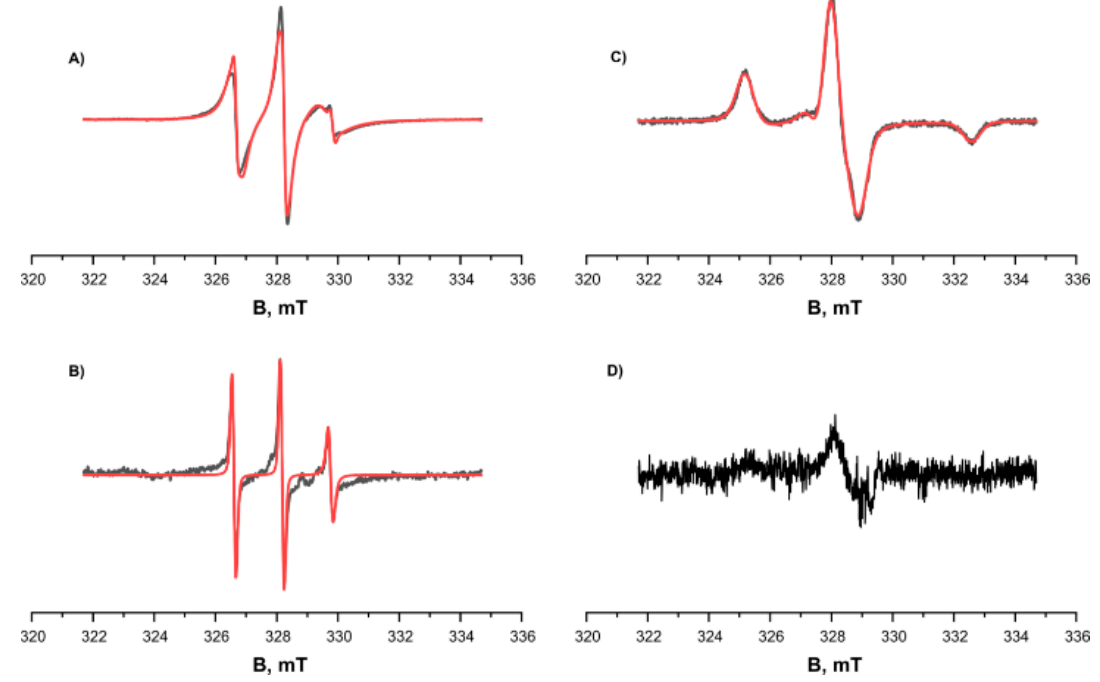
Figure 4. CW EPR spectra of RL2-MTSL at di ff erent temperatures and di ff erent pH levels (black curve: experimental, red one: simulated). ( A ) and ( C ) pH = 3.9, acetate bu ff er, 50% D 2 O, 50% deuteroglycerol. ( B ) and ( D ) pH = 7.5. ( A ) and ( B ) T = 300 K. ( C ) and ( D ) T = 132 K. Parameters of the = g = 2.0071, g = 2.0022, A = A = 0.5 mT, A = 3.7 mT, τ = 1.95 simulation were as follows: g xx yy zz xx yy zz corr